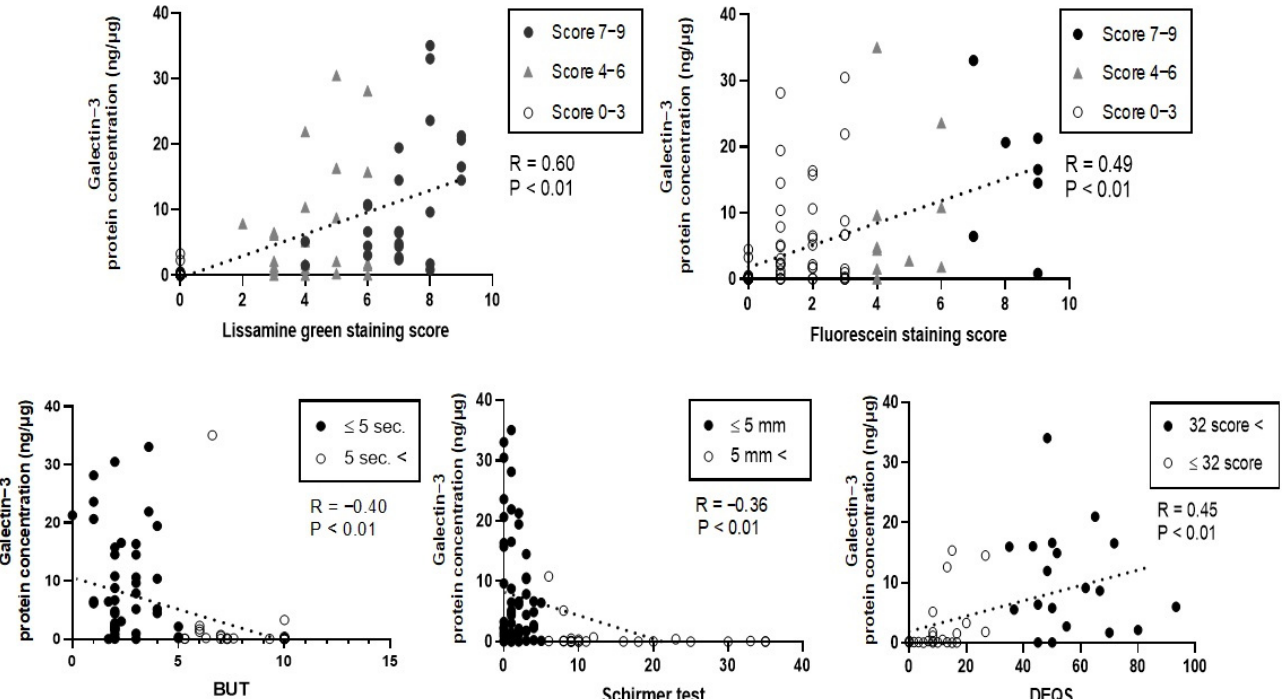
Figure 3. Correlation between gal-3 protein concentration and ophthalmic evaluation factors. Signifi- cant positive correlations were found between gal-3 concentration and LG score (R = 0.60; p < 0.01), FL score (R = 0.49, p < 0.01), and DEQS (R = 0.45, p < 0.01). Negative correlations were found between gal-3 concentration and TBUT (R = − 0.40, p < 0.01), and Schirmer’s I value (R = − 036, p < 0.01). LG, lissamine green staining; FL, fluorescein staining; DEQS, dry eye questionnaire score; TBUT, tear film break-up time.